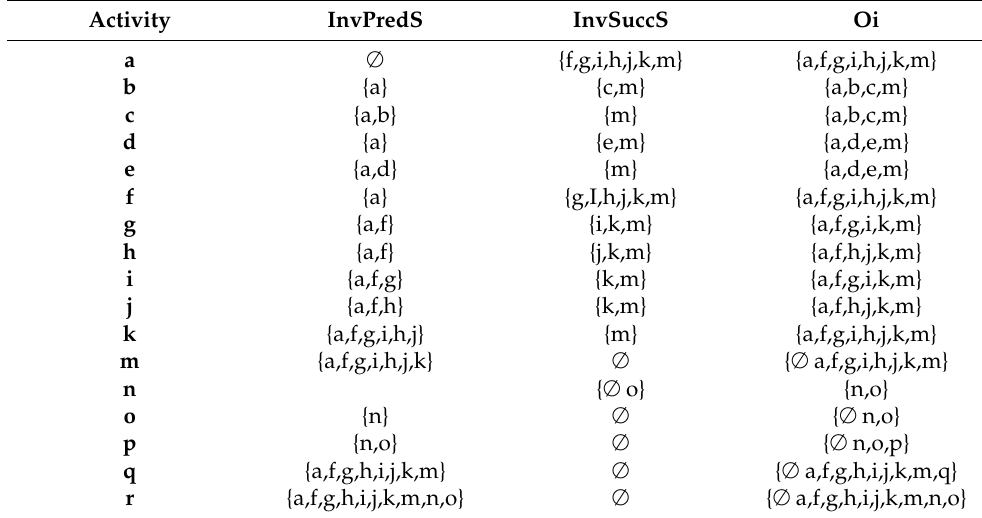
Table 4. Invariant set of all activities in the log L 2